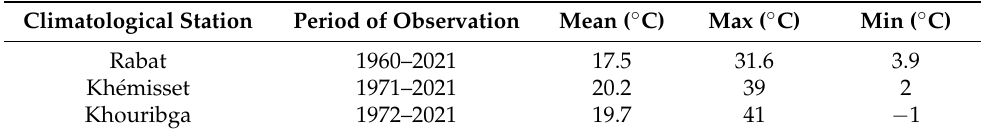
Table 3. Statistical characteristics of temperature data of the six climatological stations used. Climatological